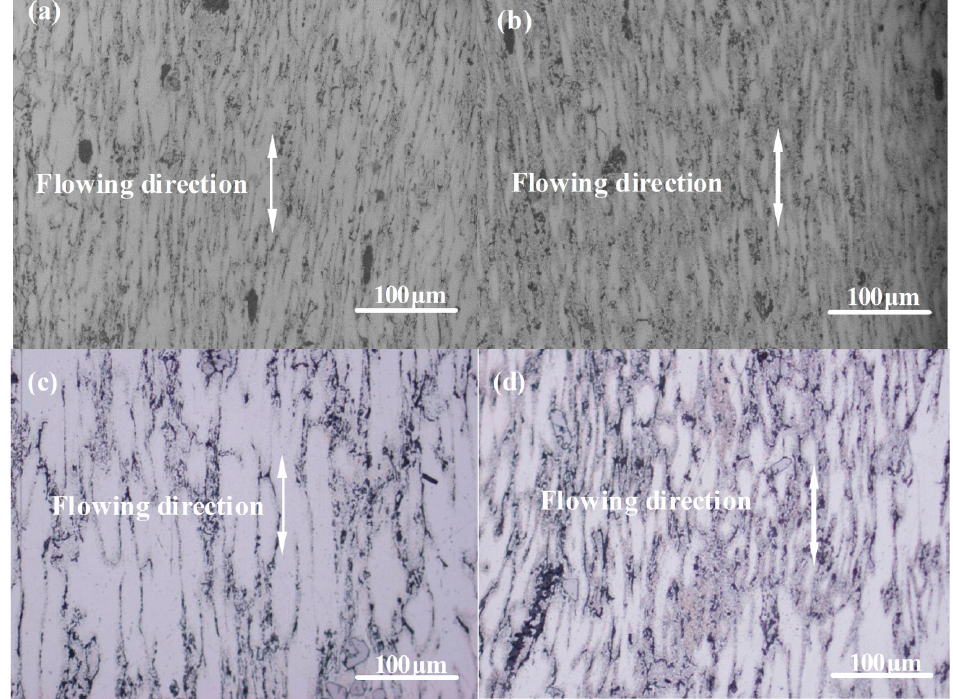
Figure 6. OM microstructure in location B of the thixoformed parts of the nano-sized SiCp/7075 composite soaked for 10 min at different remelting temperatures: ( a ) 580 °C, ( b ) 590 °C, ( c ) 600 °C, composite soaked for 10 min at different remelting temperatures: ( a ) 580 ◦ C, ( b ) 590 ◦ C, ( c ) 600 ◦ C, and and ( d ) 610 °C. ( d ) 610 ◦